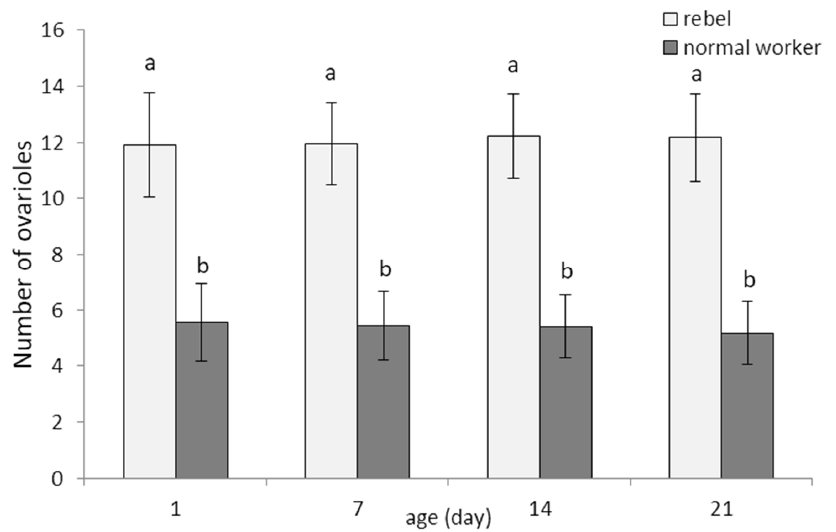
Figure 1. Number of ovarioles (mean ± SD) in normal workers and rebels. Lowercase letters indicate significant differences between averages for the rebels and normal workers within a specific age with p < 0.01; No. of rebels = 60; no. of normal workers = 60. Phagocytic index (%; mean ± SD) in hemolymph of normal workers and rebels are shown in Figure 2. The phagocytic index decreased with the age in both sub-castes, quicker in normal workers, and was higher in the rebels compared to normal workers in four tested age groups (Figure 2; two-way ANOVA with multiple comparison testing using the post hoc Tukey HSD test; age F (3,232) = 248.67; p < 0.0001; castes/sub-caste F (1,232) = 1265.7; p < 0.0001, post-hoc for each group max. p = 0.941535; castes/sub-caste*age F (3,232) = 124,54, p < 0.0001, post-hoc for each group max. p = 0.996101; no. of rebels = 60; no. of normal workers = 60).